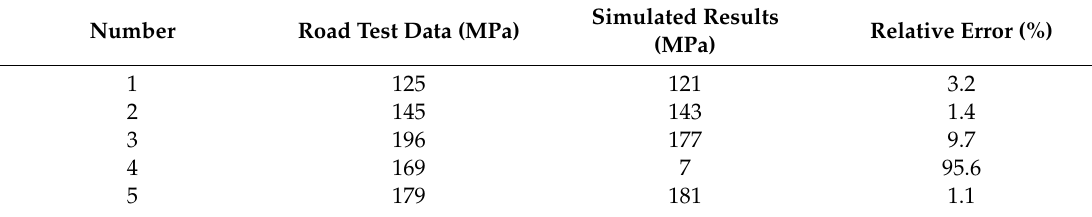
Figure 3. The strain gauge rosette on the component. Table 3. Comparison of simulated results and experimental data.